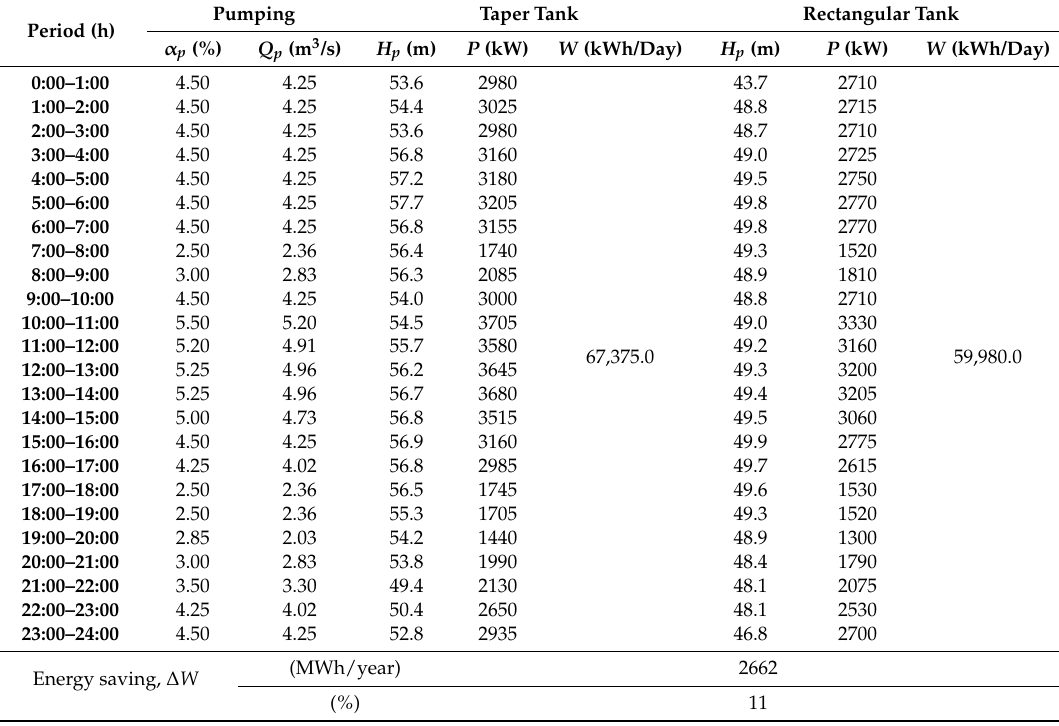
Table 3. Computation of energy consumption for water distribution using elevated